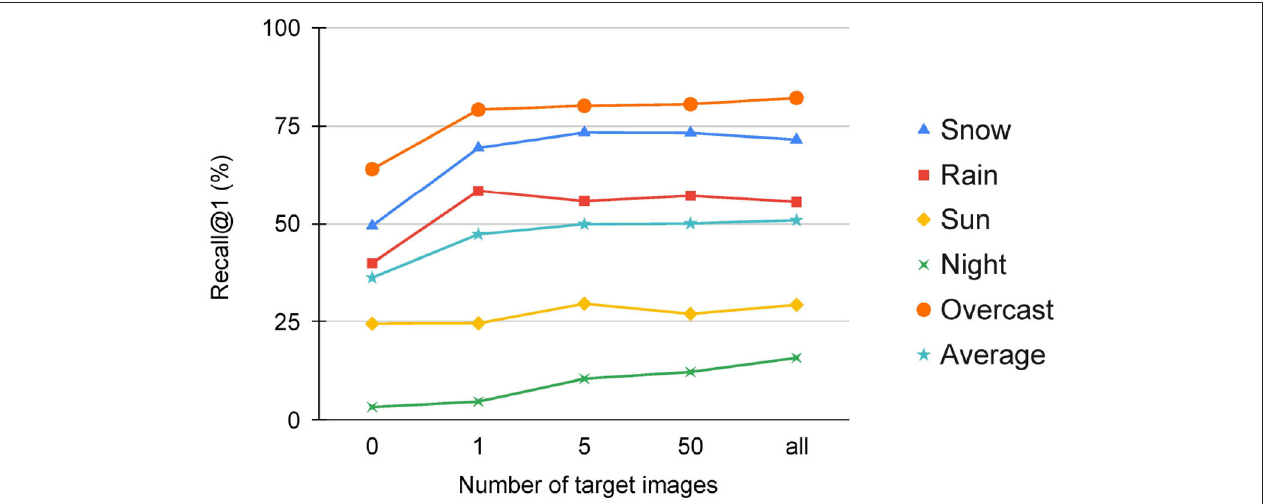
FIGURE 7 | Results of experiments with AdAGeo with 0-shots, 1-shot, 5-shots, 50-shots, and all-shots. With easier domains (Snow, Rain, Overcast), AdAGeo shows a good improvement in accuracy with just 1 target domain image, while with more challenging domains (Sun, Night), AdAGeo requires a higher amount of images to perform significant